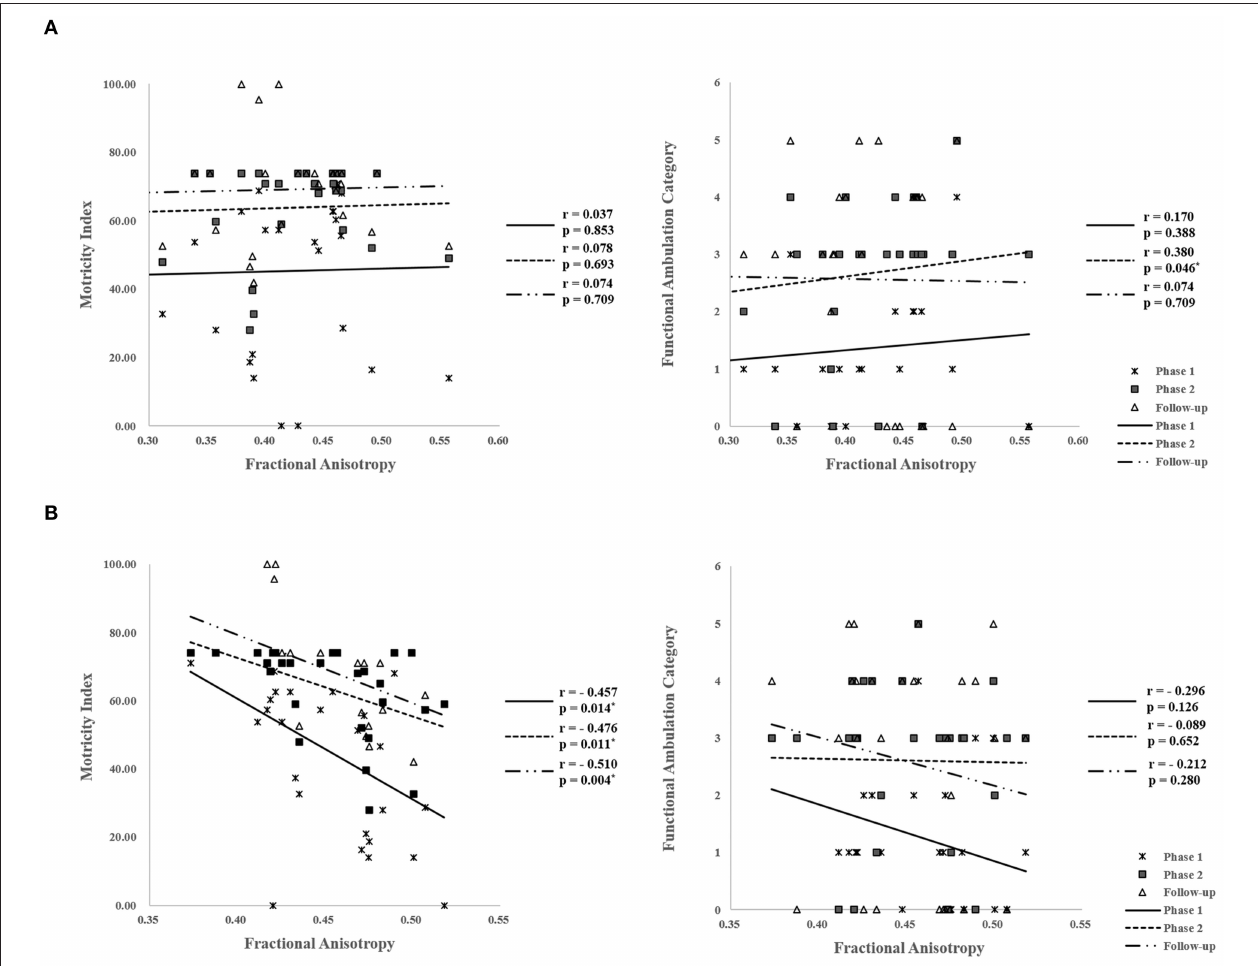
FIGURE 3 | (A) Affected hemisphere. Correlations between motor function and fractional anisotropy (FA) of diffusion tensor imaging (DTI) parameters in the affected hemisphere according to recovery process. (B) Unaffected hemisphere. Correlations between motor function and fractional anisotropy (FA) of diffusion tensor imaging (DTI) parameters in the unaffected hemisphere according to recovery process. * p <